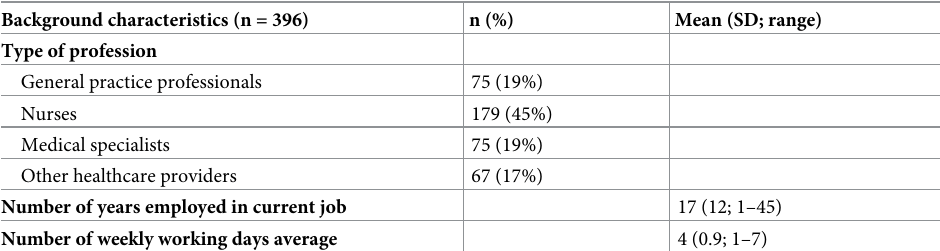
Table 1. Background characteristics survey respondents.